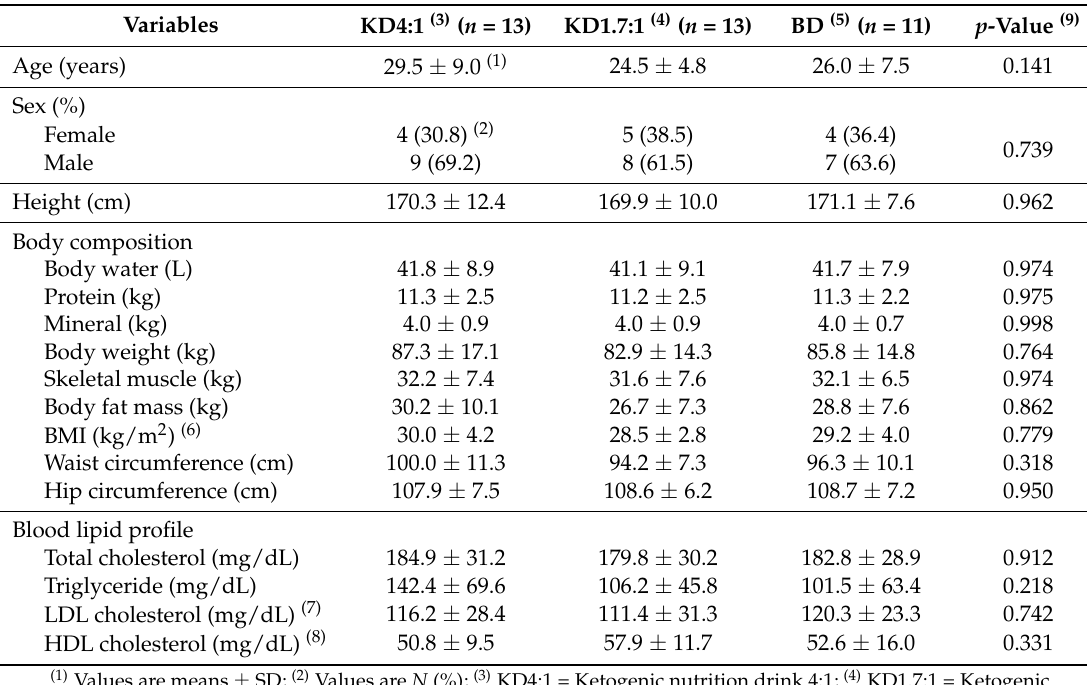
Table 2. Baseline characteristics of the study participants.